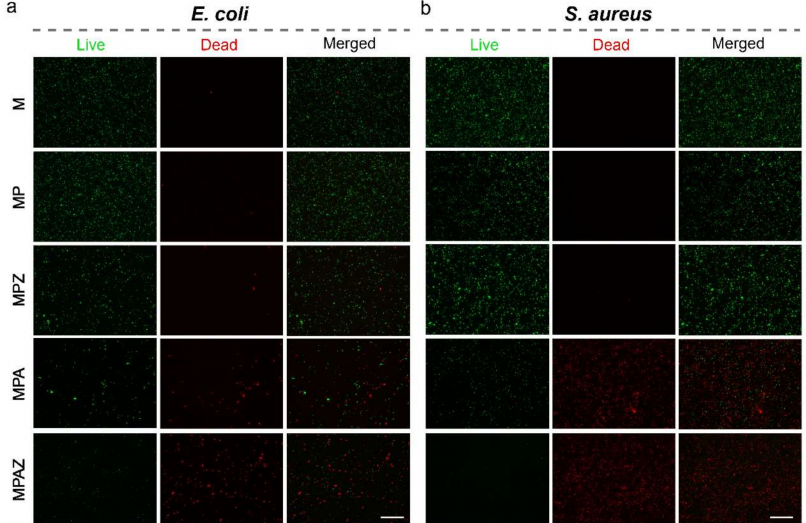
Figure 8. LIVE/DEAD BacLight cell viability assay. Fluorescence staining of E. coli ( a ) and S. aureus ( b ) cells after culture in the presence of different films. Scale bar, 50 µ